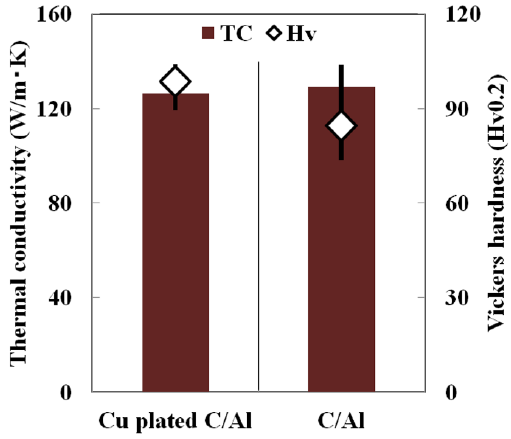
Figure 16. Vickers hardness (shown in points) and thermal conductivity (shown in bars) of Cu plated C/Al SLM composite and C/Al SLM composite.